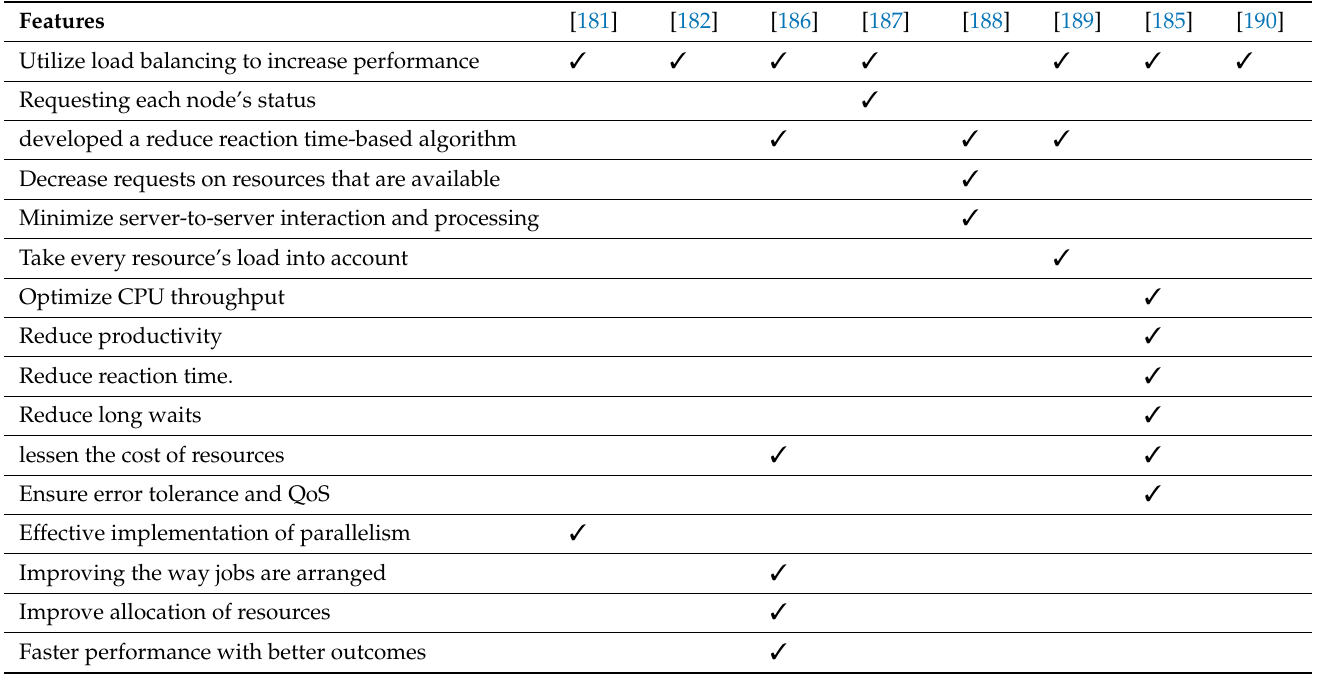
Table 4. Distributed Parallel